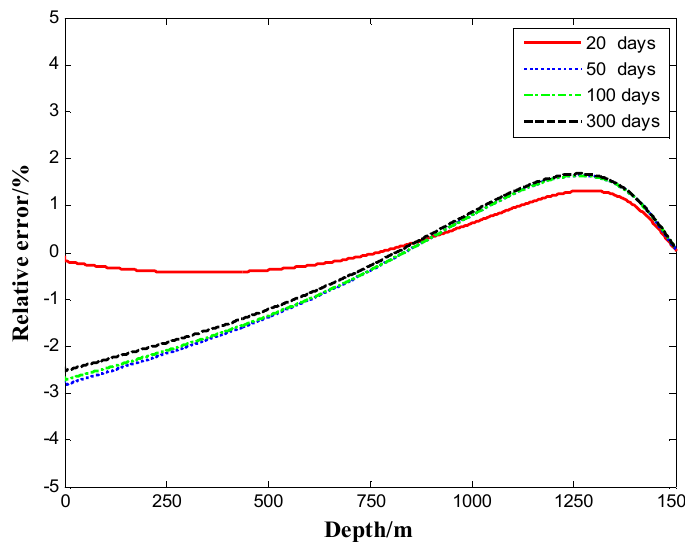
Figure 9. Error analysis of the temperature of proposed model and Hasan analytical solution with different production times.